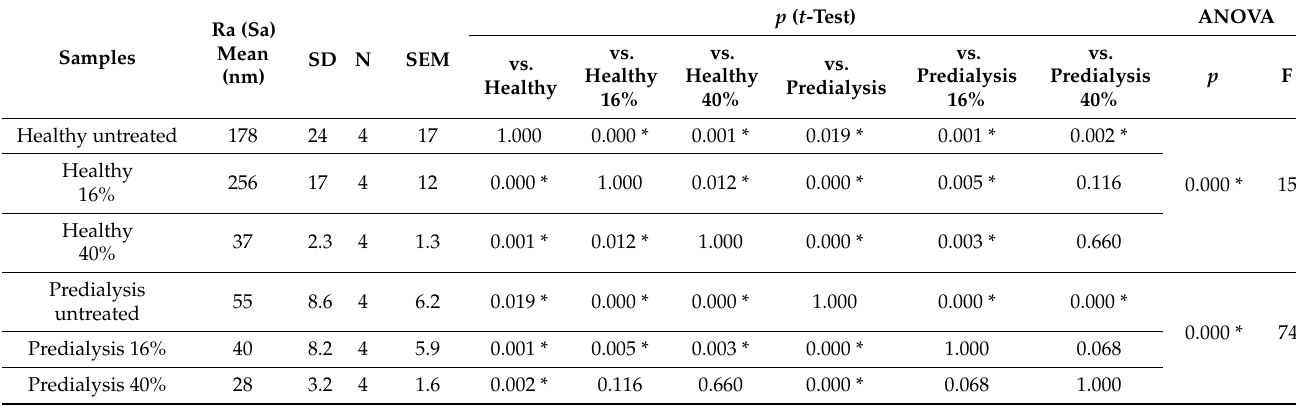
Table 2. Mean values and standard deviation for roughness.